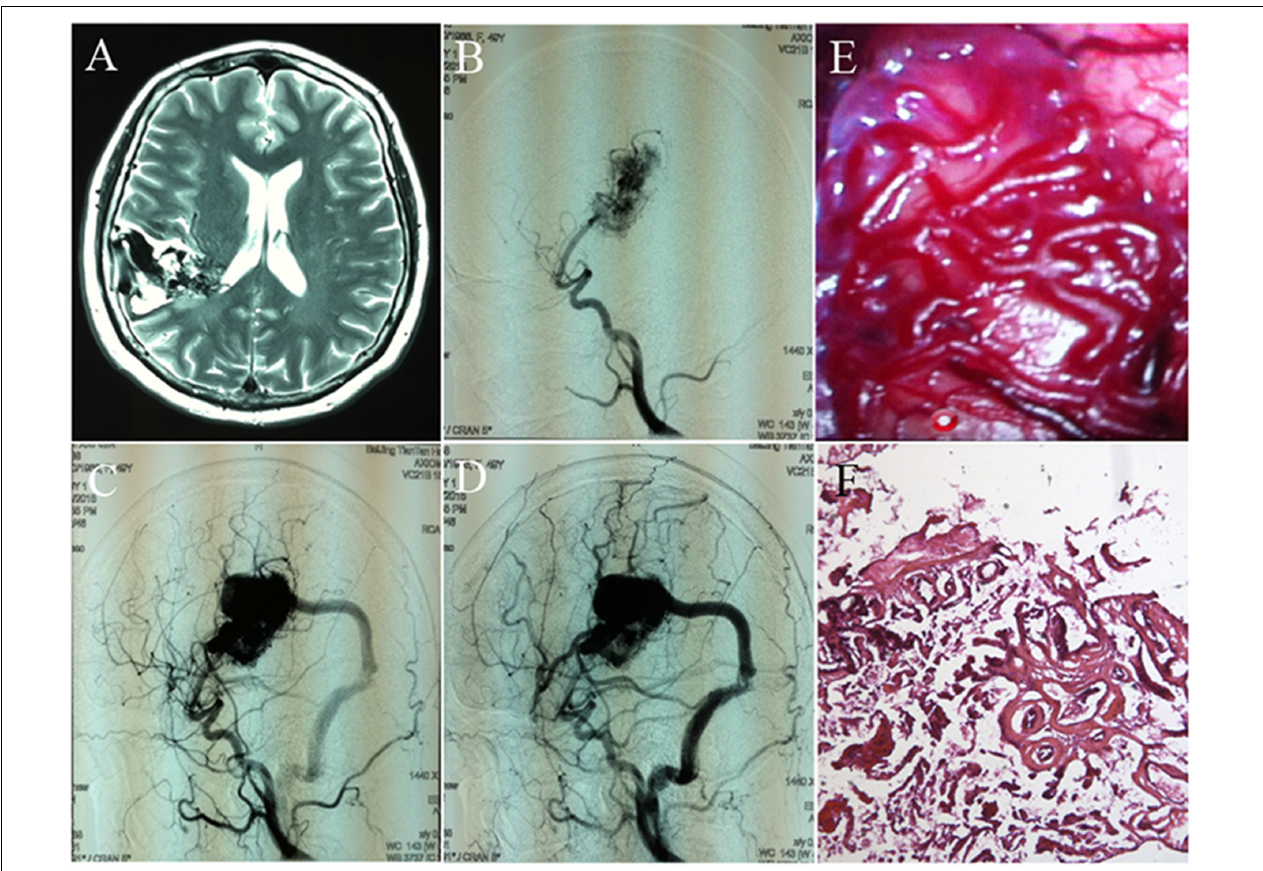
FIGURE 1 | Images and histology of cerebral arteriovenous malformation (cAVM). (A) T2WI of MRI imaging; (B–D) digital subtraction angiography (DSA) showed cerebral middle artery as the feeder artery provided blood to the cAVM nidus, which connected to the sigmoid sinus through a thick draining vessel; (E) morphology of cAVM viewed under the operational microscope; (F) photomicrograph of cAVM with deformed vascular walls from the nidus of the AVM. It had numerous collagen fibers, lacked smooth muscle and elastic fibers with incomplete wall